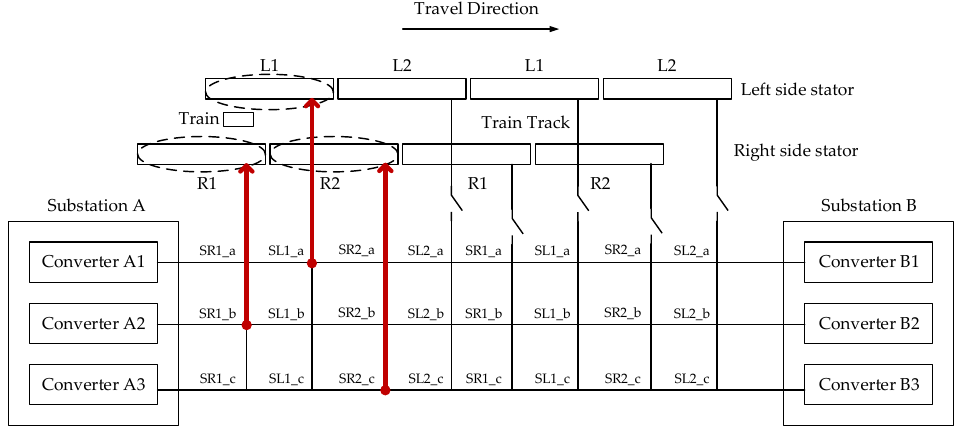
Figure 11. Demonstration of the switching process of the three-step method (Circumstance 1).